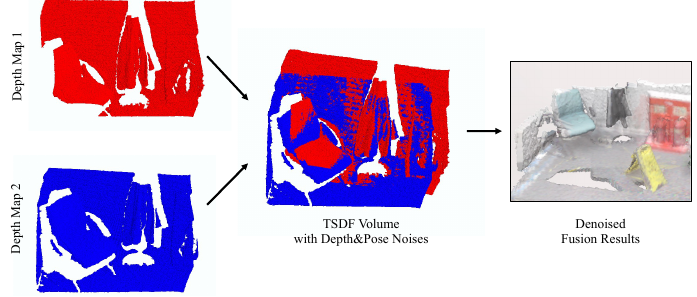
Figure 2. DFusion can minimize the influence of both types of